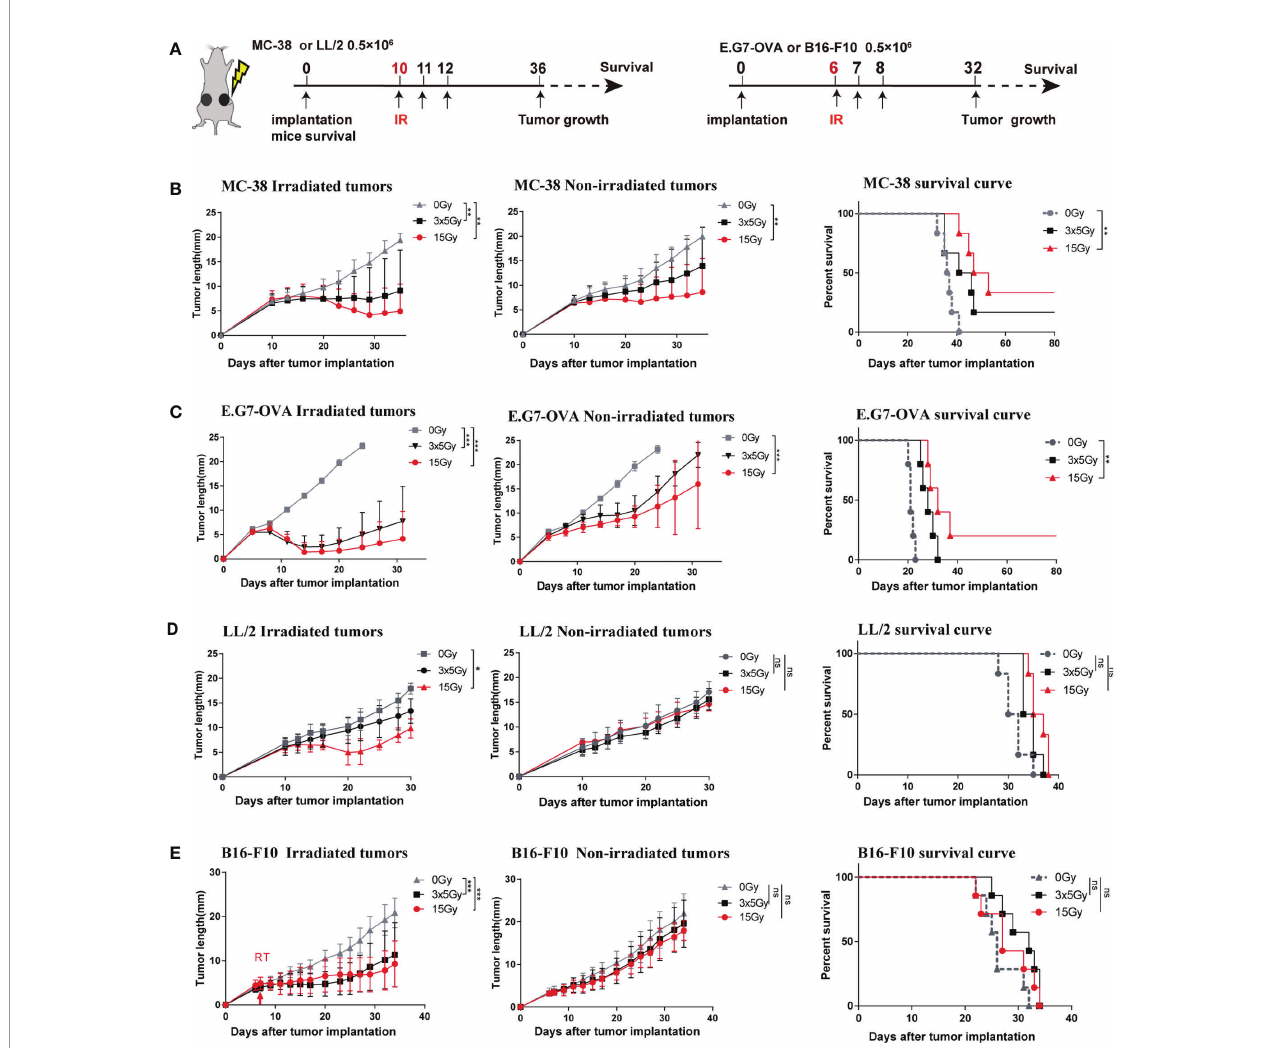
FIGURE 2 | Response to radiotherapy in highly and poorly immunogenic tumors. (A) Four types of murine tumor cells were subcutaneously inoculated in the bilateral fl anks of C57BL/6 mice. Irradiated (in the right fl ank) tumors received 3 × 5 Gy, 15 Gy or sham radiation when tumor lengths reached 5 – 6 mm. (B – E) Left: Tumor growth curve of irradiated and non-irradiated tumors treated with 3 × 5 Gy, 15 Gy or sham radiation in the (B) MC-38 model (n = 12), (C) E.G7-OVA model (n = 10), (D) LL/2 model (n = 12) and (E) B16-F10 model (n = 12); Right: Survival rate of the mice in each group for the MC-38, E.G7-OVA, LL/2 and B16-F10 models. Percent survival of mice in the different groups depicted with a Kaplan – Meier plot. One-way ANOVA was used to compare tumor sizes at the endpoint of these three groups * p < 0.05, ** p < 0.01, *** p < 0.001, ns, no signi fi